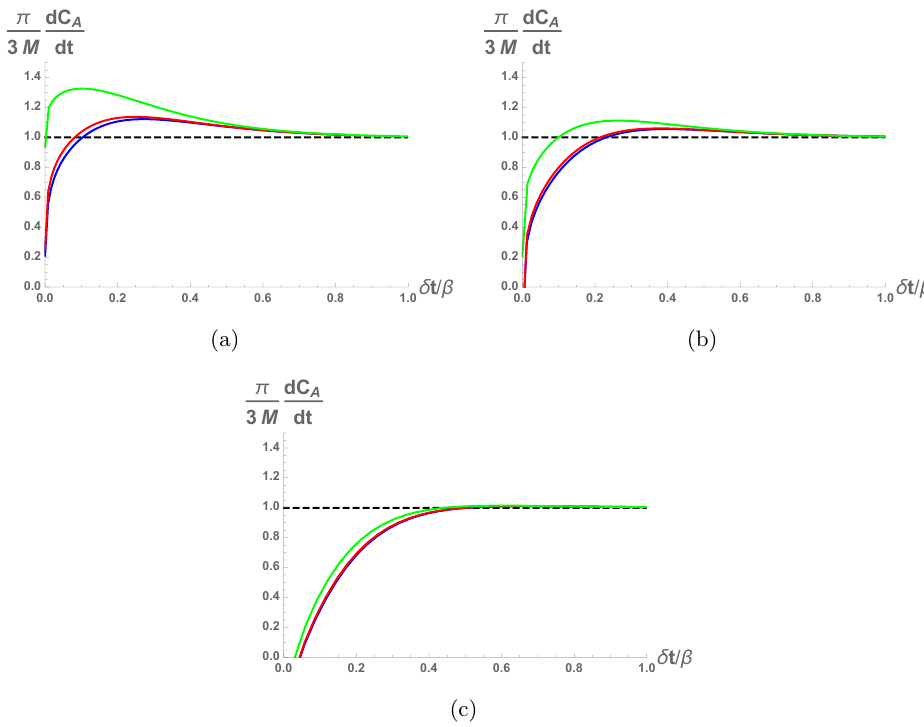
Figure 5 . dC A is plotted against the dimensionless quantity (cid:14)t=(cid:12) for d = 3 and n = 1. here (cid:12) is dt inverse temperature. Panel (a) shows the variation of dC A (c) for r h = 3 : 5. In each panel blue, red and green curves correspond to a = 0 : 05, a = 0 : 1 and a = 0 : 5 respectively. In all cases, the dotted line represents the ratio (cid:25) the constants c; (cid:22) c = 1 have been set for